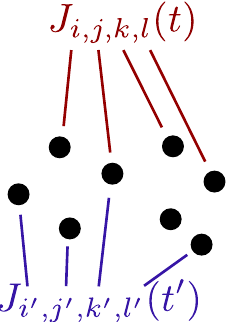
Figure 1 . Pictorial representation of the Brownian SYK model described by the Hamiltonian (2.1), for q = 4. At each time, all the Majorana fermions are coupled together within clusters of q particles, with time-dependent random